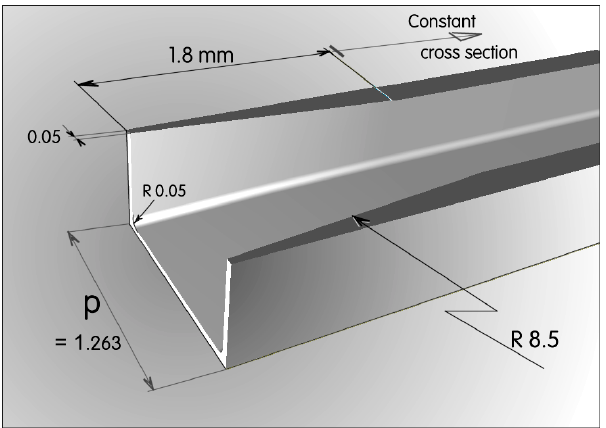
Figure 6. Details of the typical gradual reduction of the flow area at the entrance into the matric passage (the axial view is in Figure 2). Indicated dimensions are those of the investigated matrix type A. The same gradual wall thickness variation is at the passage exit.